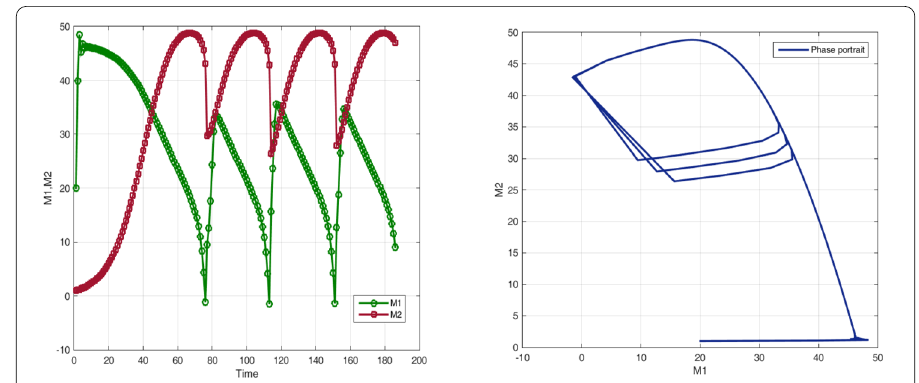
Figure 10 Dynamics of interaction for M 1 (0) = 20, M 2 (0) = 1, a 1 = 0.03, b 1 = 0.9, V = 100, a 2 = 0.16, b 2 = 0.07, a 3 = 0.32, n = 0.99, m =